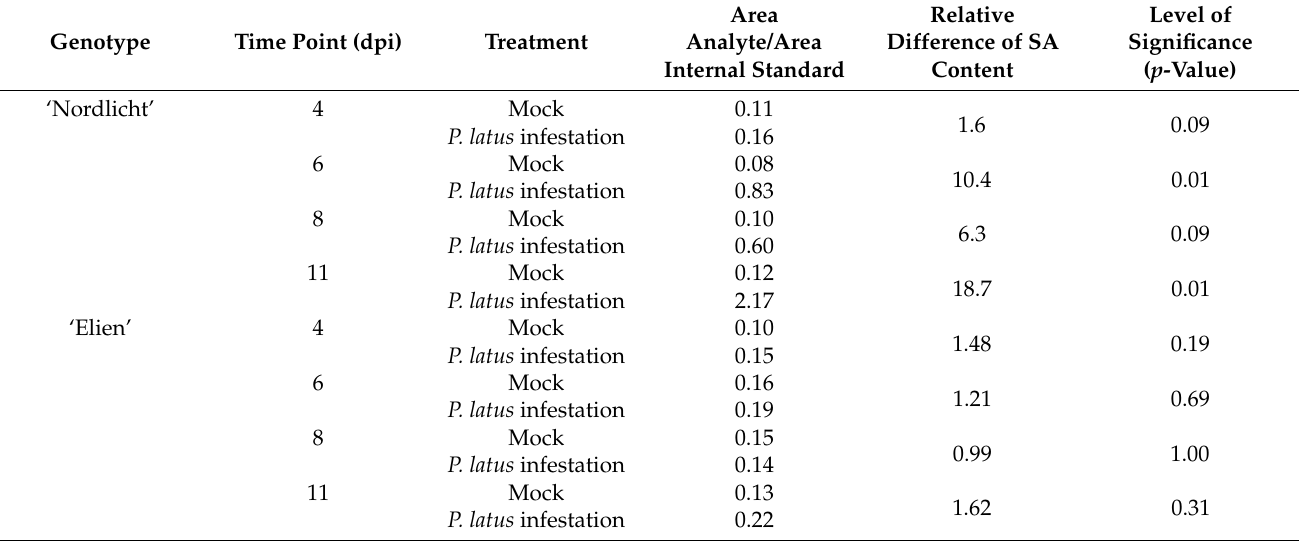
Table 2. The relative difference in salicylic acid content in the pot azaleas ‘Nordlicht’ and ‘Elien’. Leaflets are analyzed 4, 6, 8 and 11 days post-infestation (dpi) with Polyphagotarsonemus latus or mock treatment (experiment 1). Relative differences are calculated as the ratio of area analyte/internal standard of infested leaves and mock treatment ( n = 5) (Mann–Whitney U, p -values are